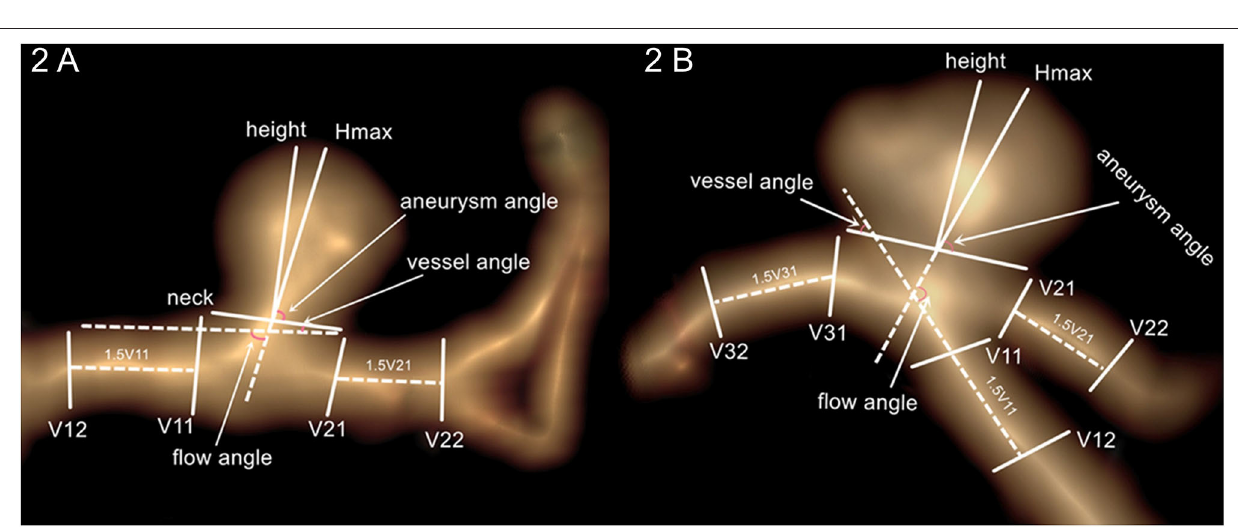
of vessels surrounding an aneurysm. Aspect ratio was the ratio of perpendicular height to neck size. Size ratio was the ratio of aneurysm height to vessel size. Vessel angle was the angle between the vector of blood flow and the plane of aneurysm